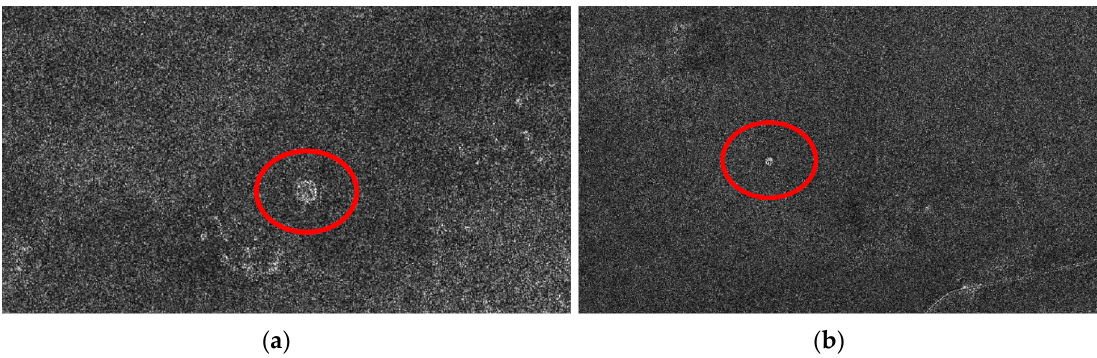
Figure 6. TerraSAR-X slant-range strip map HH image of ( a ) Tunnug 1 and ( b ) Arzhan 5 . © DLR, 2013.